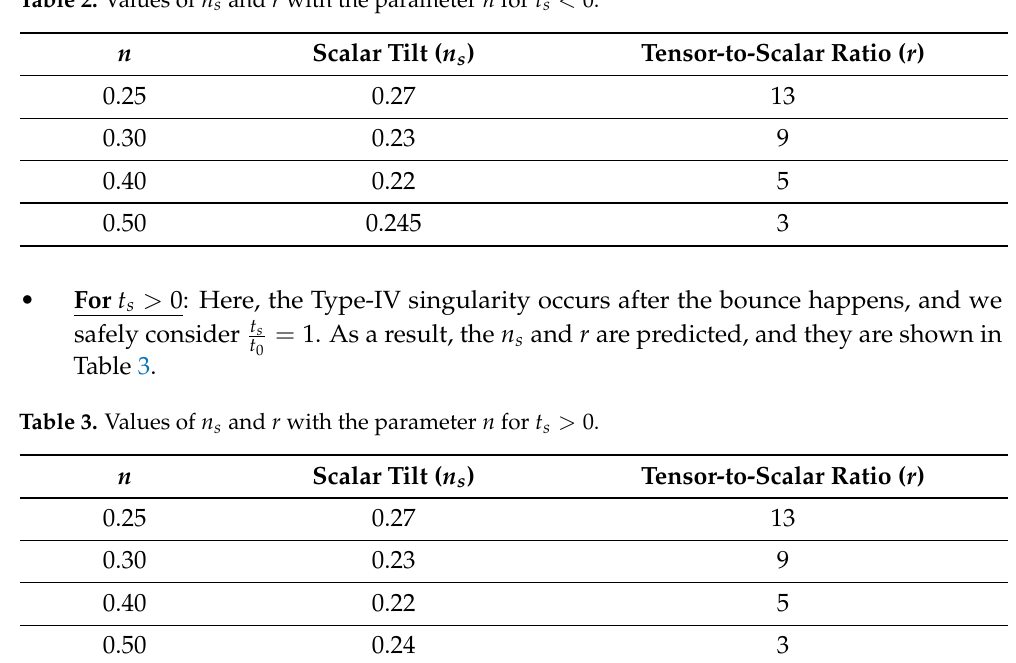
Table 2. Values of n s and r with the parameter n for t s < 0.